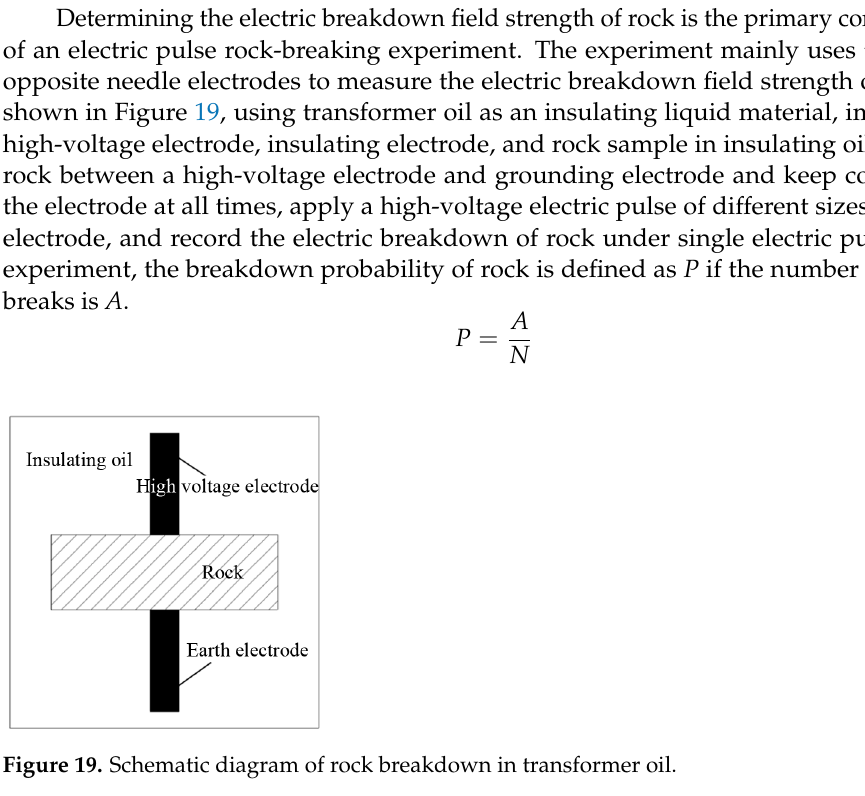
Figure 20. Fixture model of rock electrical breakdown experiment. The internal structure of the rock under the electron microscope is shown in Figure 21a, which shows the internal structure of the sandy conglomerate. Figure 21b shows the internal structure of purplish red mudstone. It can be seen that the interior of the rock is uneven, and there are some pores at the junction of particles. ( a )